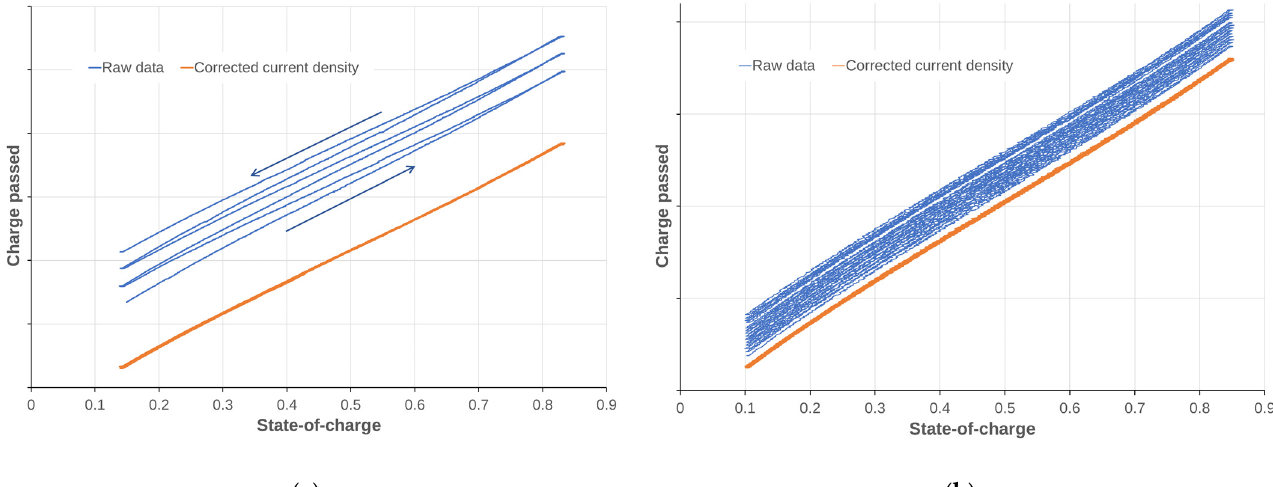
Figure 4. Repeated cycles of a vanadium redox flow cell at 100 mA cm − 2 showing the cumulative electrical charge passed (raw data) and the charge passed after correcting j by a constant j sd term (corrected current density) arranged against the measured SOC of the electrolyte, for ( a ) cycles 4 to 6 of a cell with cation exchange membrane at 25 °C and ( b ) cycles 4 to 17 of a cell with anion exchange membrane at 30 °C.